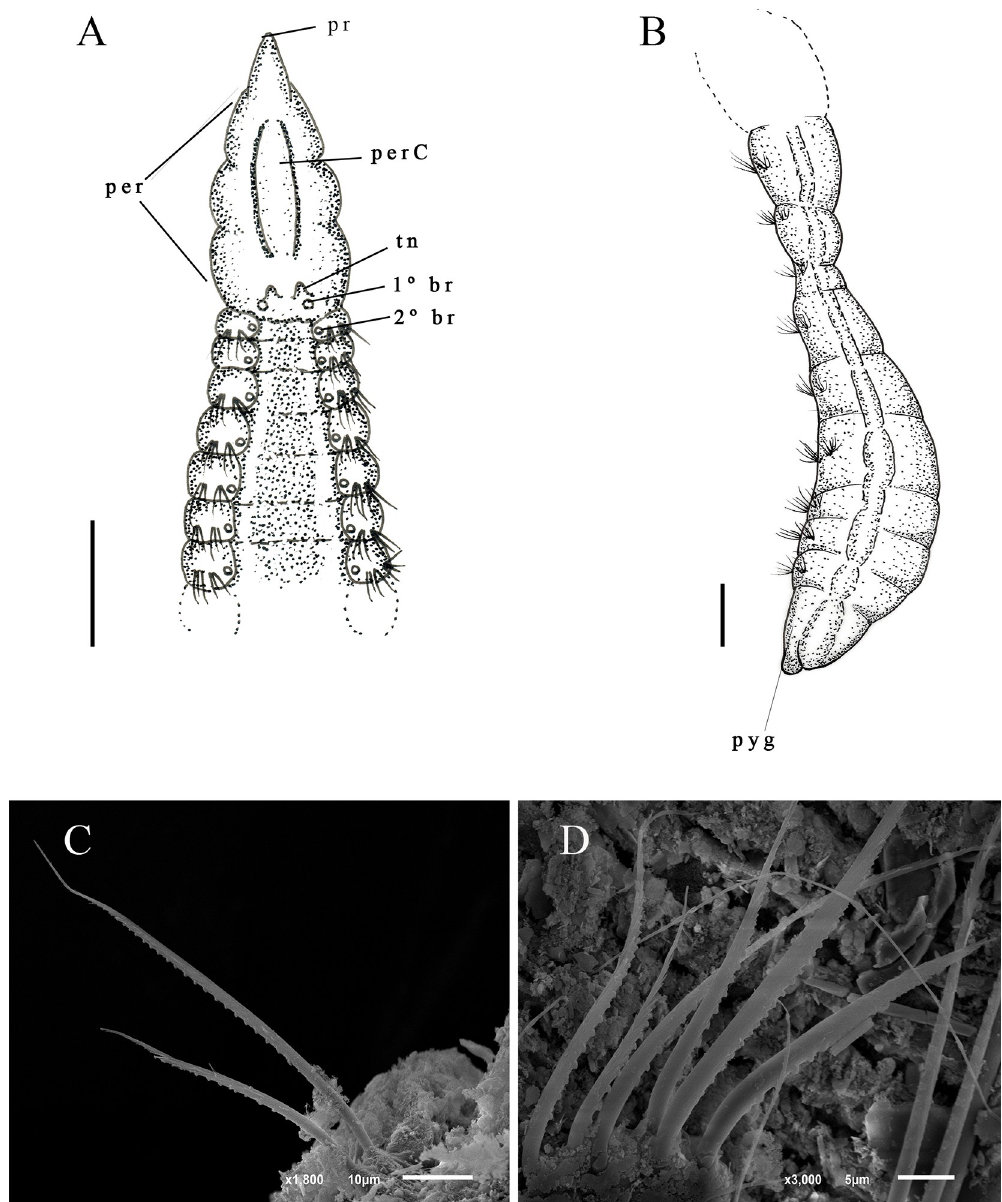
Fig 7. Kirkegaardia jongo sp. nov. (A) anterior end, dorsal view; (B) posterior end, lateral view; (C) denticulated notopodial capillary; (D) denticulated neuropodial capillary. A–B (MNRJP-002997). Scale bars: 100 μ m (A and B). Type locality. Atlantic Ocean: Campos Basin (Brazil). Habitat. Fine sediments composed of silt and clay, or sand, depth between 352 to 1288m. Distribution. Presently known only from Atlantic Ocean: Campos Basin (Brazil). Methyl Green. No pattern, stain not